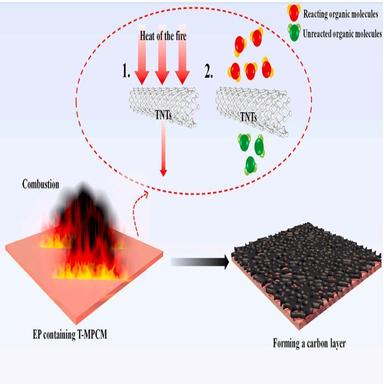
The flame retardant effect of TNTs in EP composites.